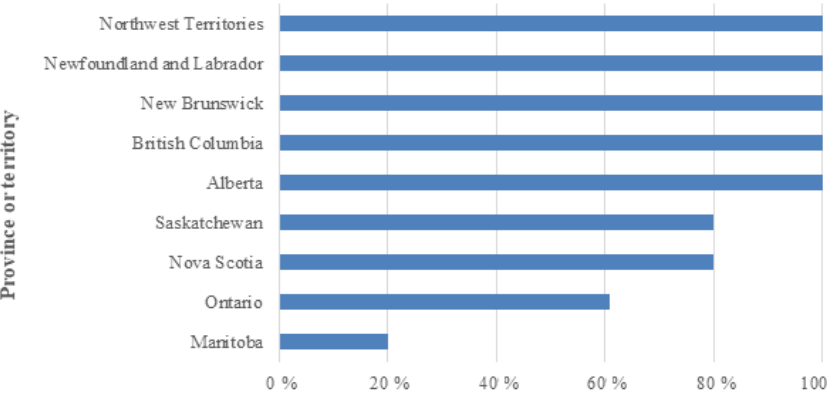
Figure 1. Municipalities in the study area with available flood maps.